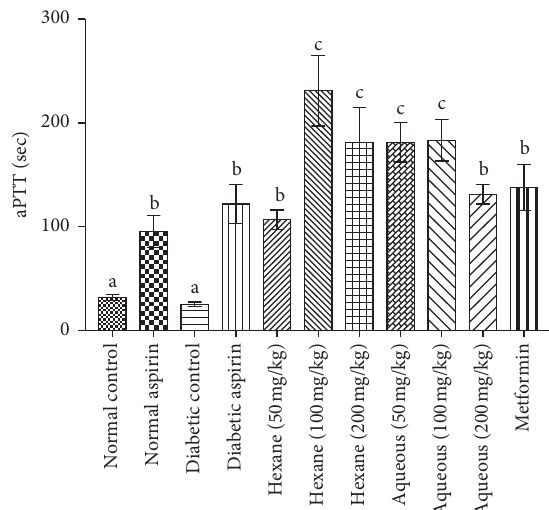
Figure 4: Activated partial thromboplastin time (aPTT) in diabetic rats treated with different concentrations of aqueous and hexane fractions of C. crepidioides . Bars with different letters are signifi- cantly different ( n � 4); b is significantly higher than a at P < 0 . 001 c is significantly higher than a at P < 0 . 0001. b is significantly lower than c at P <